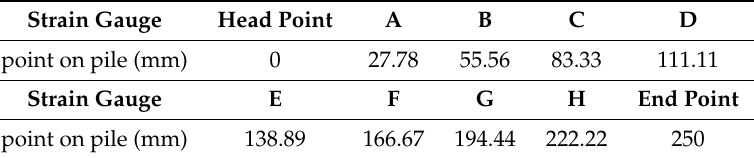
Table 7. Physical properties of Jumunjin sand polycarbonate.